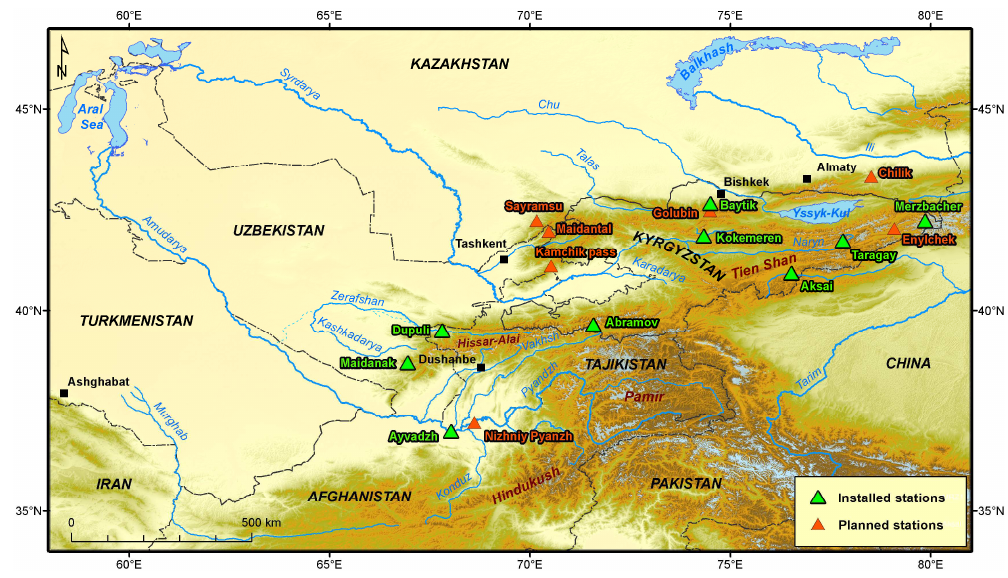
Fig. 1. The region of Central Asia (including northern Afghanistan) and the state of the ROMPS network by November, 2012. 3 In the past decades, hydrometeorological monitoring in Central Asia was largely based on manned outposts.